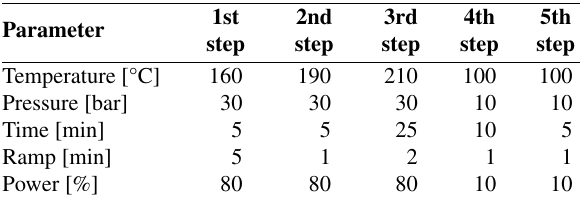
Table 3. Program of microwave digestion